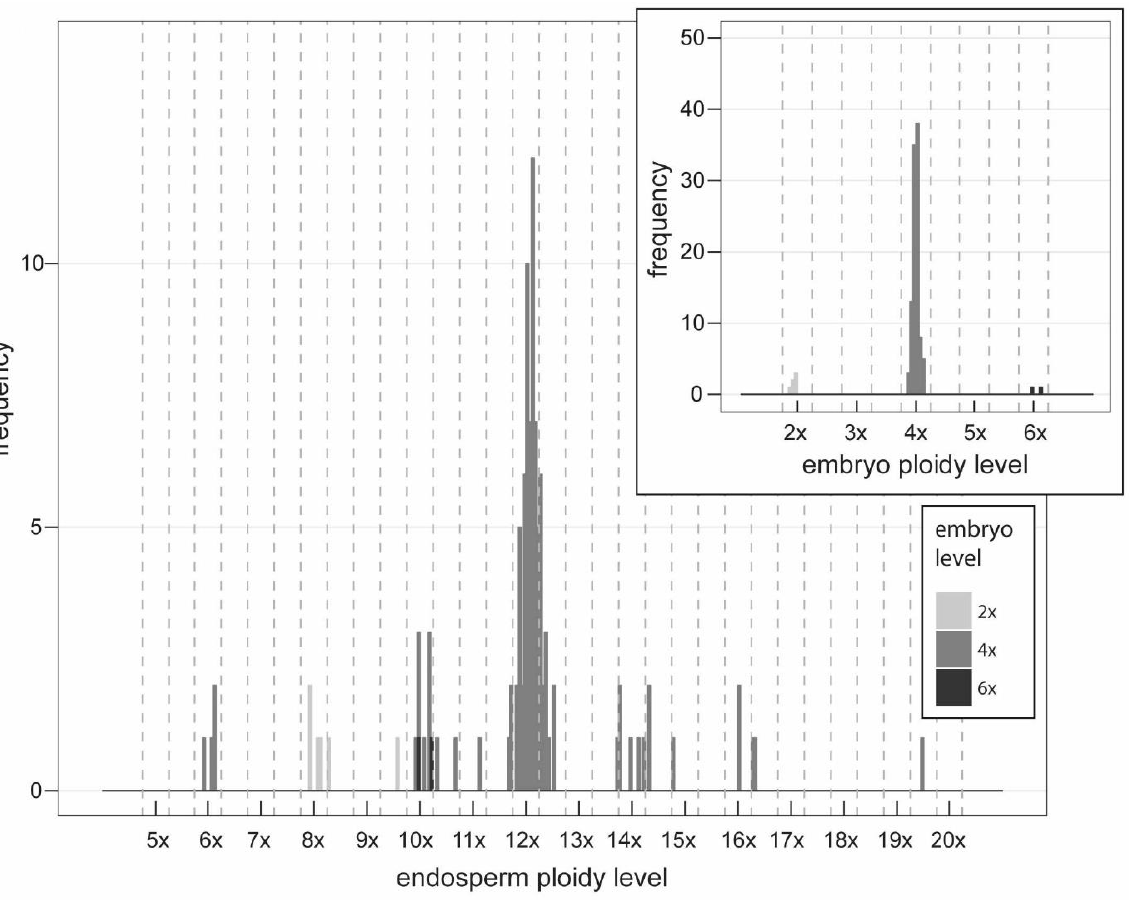
Figure 5. Calculated embryo (in inset) and endosperm ploidy levels from 8 tetraploid mother trees of Crataegus . Estimated euploid and aneuploid ploidy level categories are separated by vertical dashed lines.